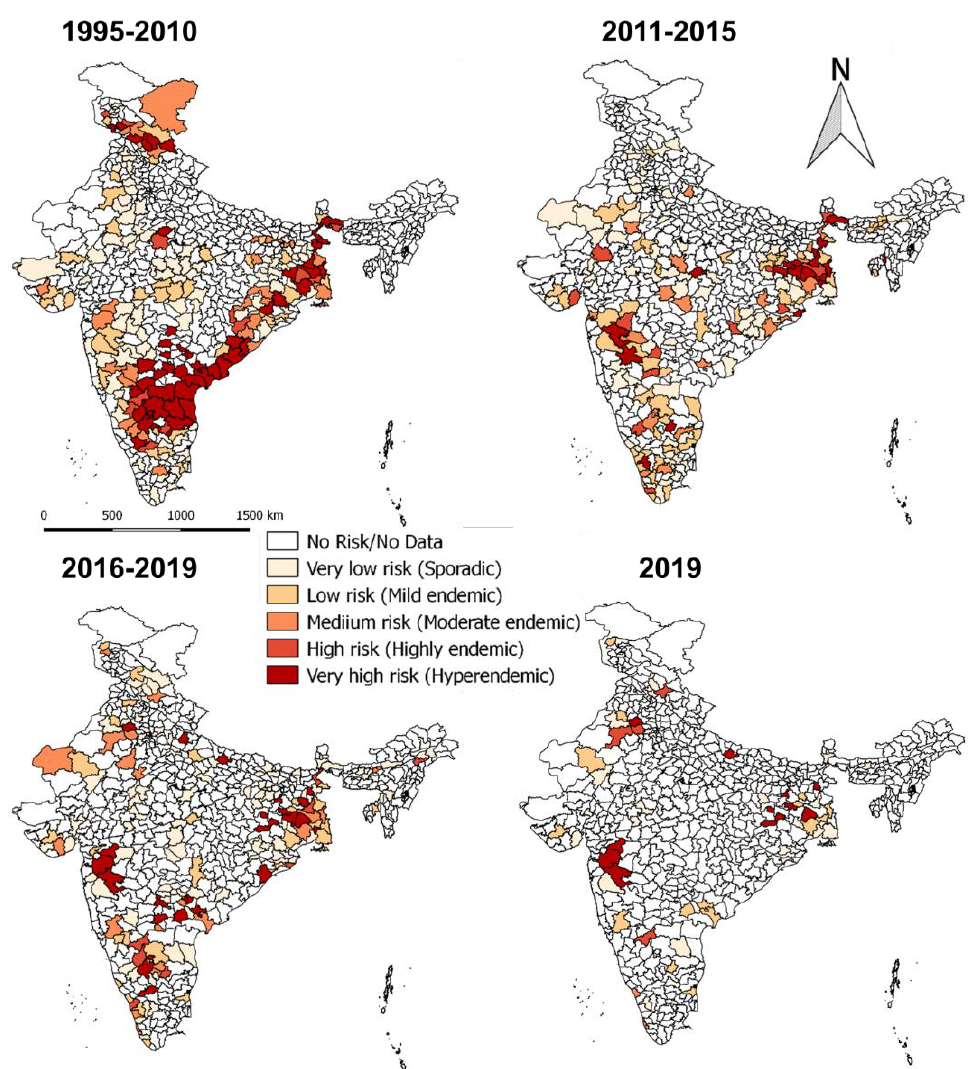
Figure 9. Endemic districts of PPR in different states of India (1995–2019). The endemicity categorization is based on the scale of the cumulative outbreaks, that occurred in the districts per year in the given period of analysis and classified as in the categories of risk, if the outbreaks numbers in the district as 0 –no risk, 1- very low, 2- low, 3- medium, 4- high and >4 very high-risk districts depicted in the map. Andhra Pradesh, West Bengal, and Karnataka states were the top three states during 1995–2010, whereas during 2011-15 and 2016–2019, Jharkhand and West Bengal states had reported more PPR outbreaks. The current status of PPR outbreaks during 2019 in different districts of India was depicted separately in the